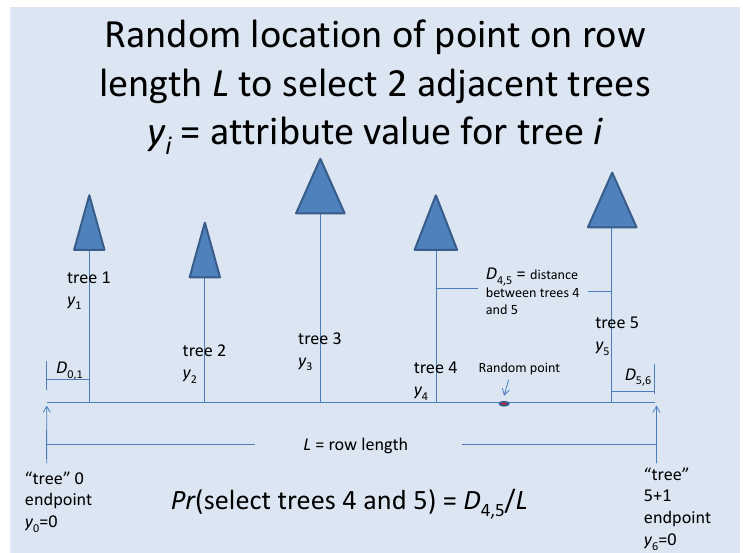
Figure 1. Ducey’s unbiased row sampling estimator with κ = 1, ˆ Y D . Equation (5) is used to select the two trees on either side of the gap into which the randomly located point, z , falls.